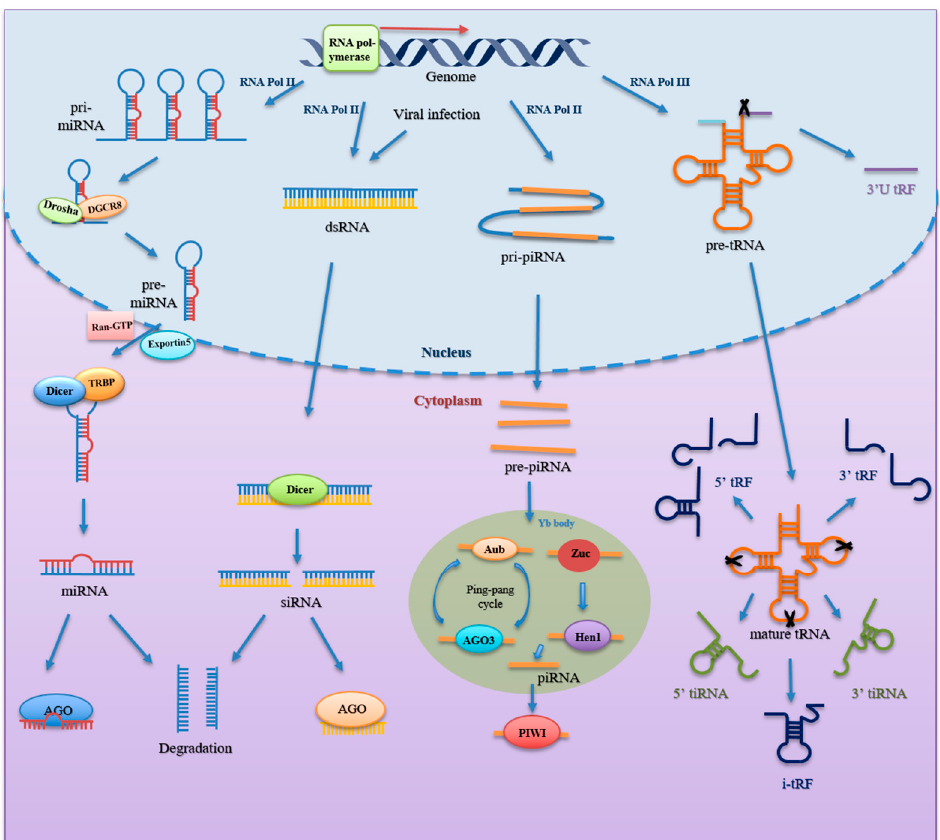
Figure 1. Formation of small non-coding RNAs. miRNA genes are transcribed by RNA polymerase (Pol) II to generate pri-miRNA, which is then processed by DGCR8 and Drosha to form pre-miRNA inside the nucleus. It is further exported to cytoplasm by Exportin5 and Ran-GTP. Dicer and TRBP in cytoplasm further cleave and process pre-miRNA into mature, short double-stranded miRNA. One strand of the mature miRNA duplex binds with Argonaute protein to form RISC, while another strand is degraded. siRNA is derived from long dsRNA produced by transcription of sense and antisense strands by RNA Pol II and viral infection. Then, dsRNA is processed by Dicer into siRNA duplex, of which one strand binds with Argonaute protein to form the siRNA-induced silencing complexes, while another strand is degraded as well. As for piRNA, piRNA genes are transcribed by RNA Pol II to produce pri-piRNA through the primary procession pathway. pri-piRNA is exported into the cytoplasm and cleaved into pre-piRNA. Then, pre-piRNA is processed by Zuc and Hen1 to form mature piRNA. Mature piRNA in complex with PIWI proteins to work. Additionally, Aub and AGO3 coupled with mature piRNA cleave transcript-bearing sites complementary to the piRNA sequence, thus amplifying mature piRNA species through the “ping-pong” cycle. As for tsRNA, after it is transcribed by RNA Pol III, pre-tRNA undergoes processes and modifications to form mature tRNA. Ribonuclease cleavage in various region of pre-tRNA and mature tRNA generates different types of tsRNAs, including 3 (cid:48) U tRF, 5 (cid:48) tRF, 3 (cid:48) tRF, i-tRF, 5 (cid:48) tiRNA, and 3 (cid:48) tiRNA. Abbreviations: miRNA, microRNA; DGCR8, double-stranded RNA-binding protein; pri-miRNA, primary miRNA; pre-miRNA, precursor miRNA; TRBP, TAR RNA binding protein; RISC, RNA- induced silencing complex; siRNA, small interfering RNA; dsRNA, double-stranded RNA; piRNA, PIWI-interacting RNA; pri-piRNA, primary piRNA; pre-piRNA, precursor miRNA; AGO3, Argonaute 3; tsRNA, tRNA-derived small